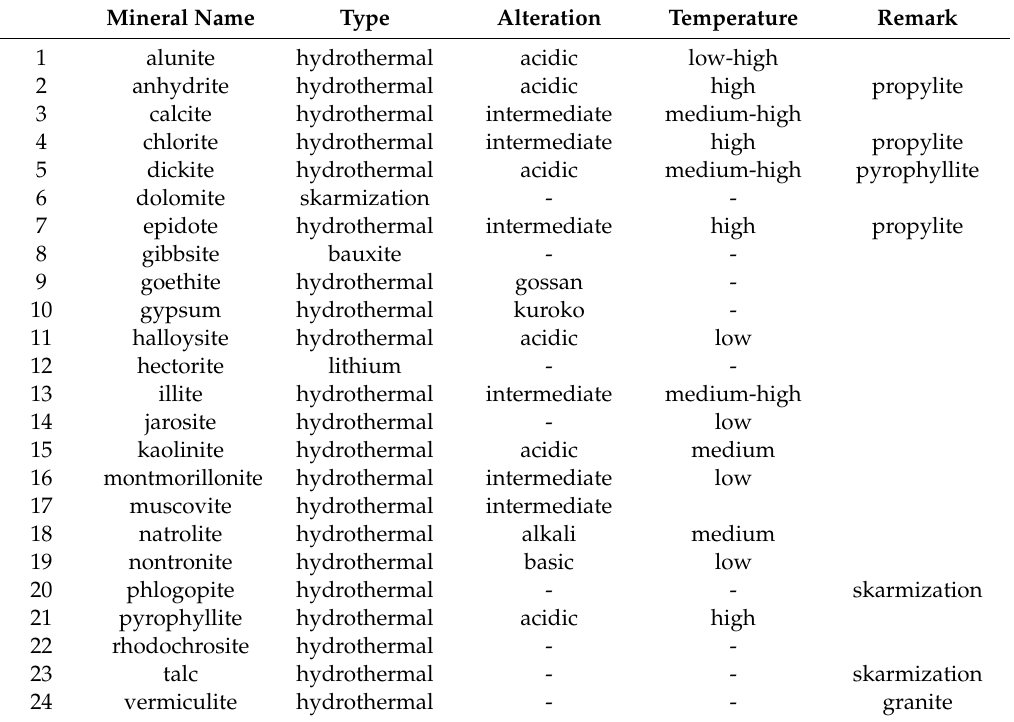
Table 1. List of target alteration